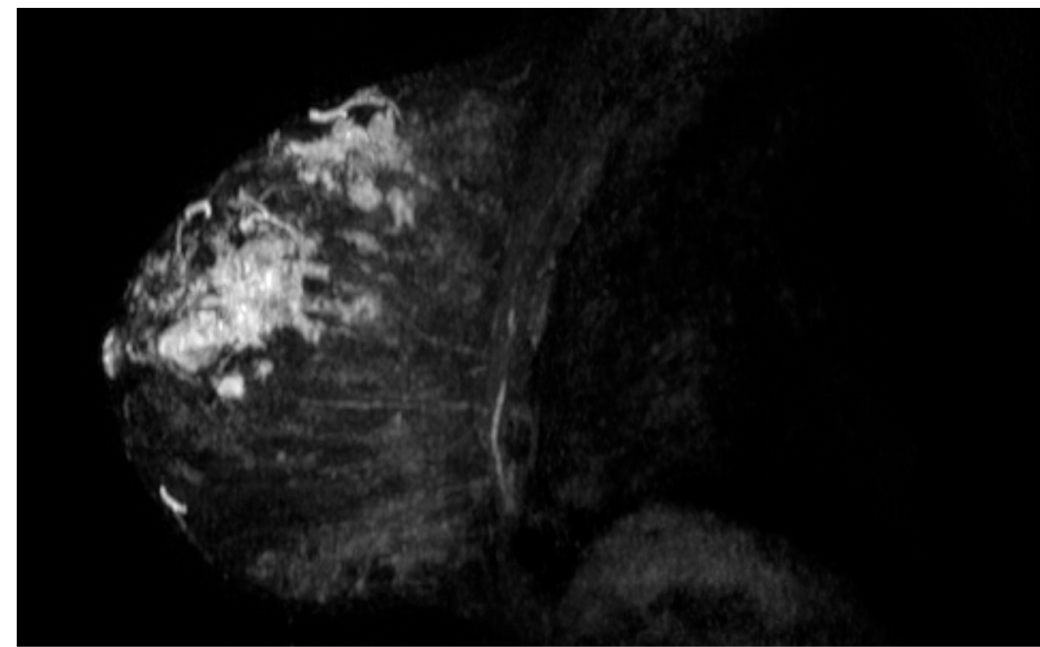
Figure 1. Magnetic resonance imaging revealing the 10 cm ductal carcinoma in the right